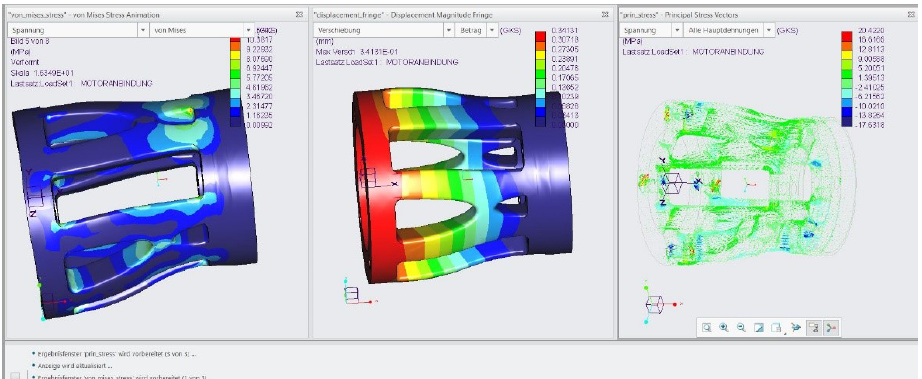
Figure 18. FEM simulation of the topology optimized motor connector—load case curb